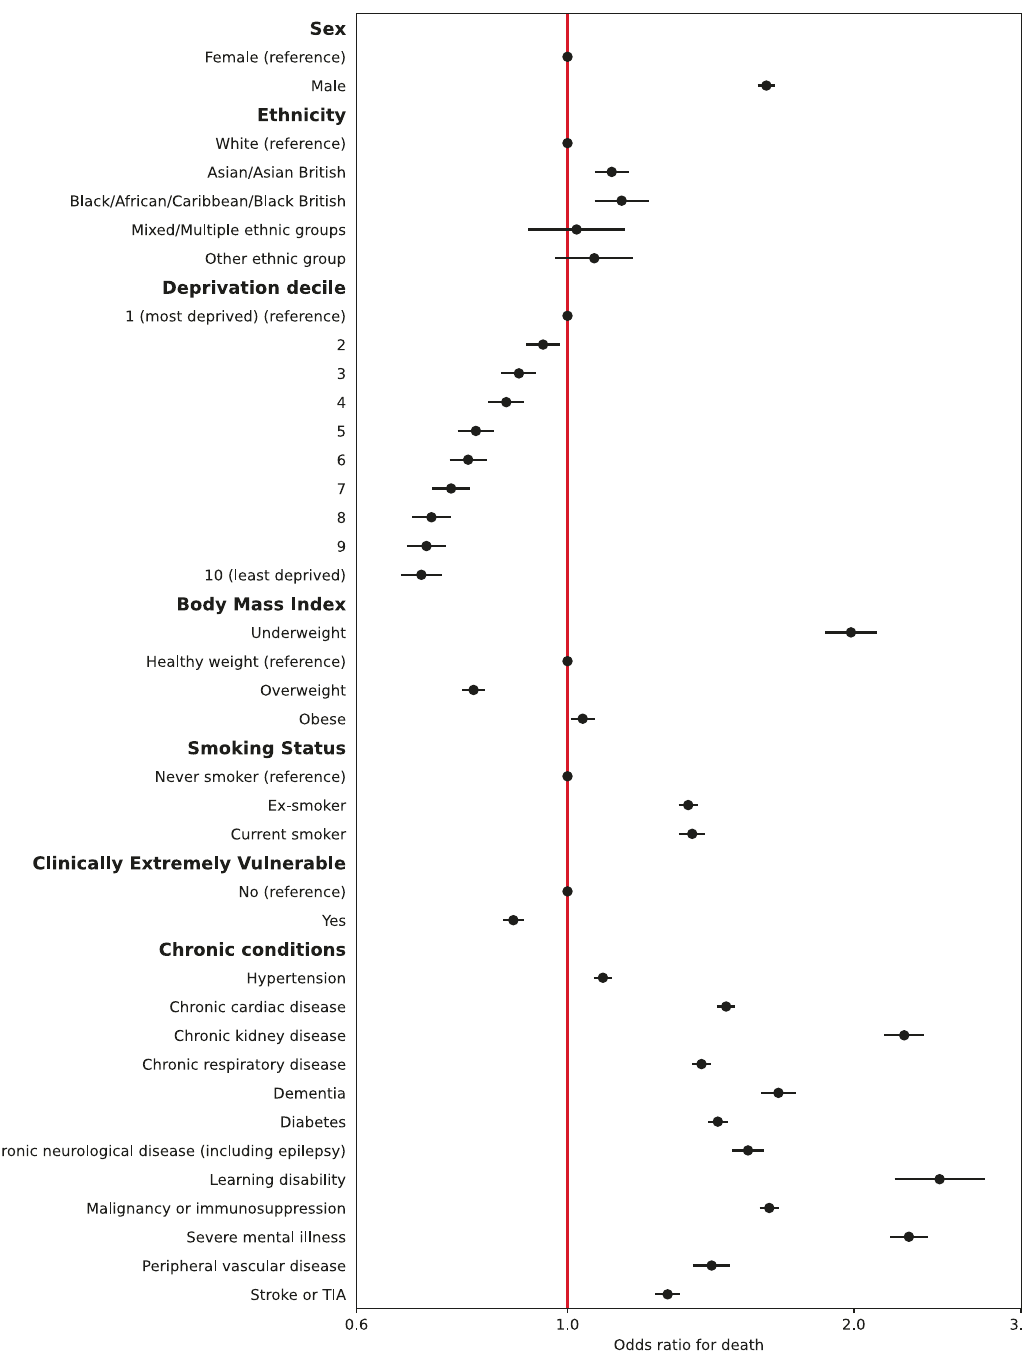
Fig. 2 Adjusted odds ratios for death within 28 days of positive Covid-19 test. Circles represent odds ratios and error bars represent the 95% con fi dence intervals for patient-level predictors from multivariable mixed effects logistic regression models ( N =